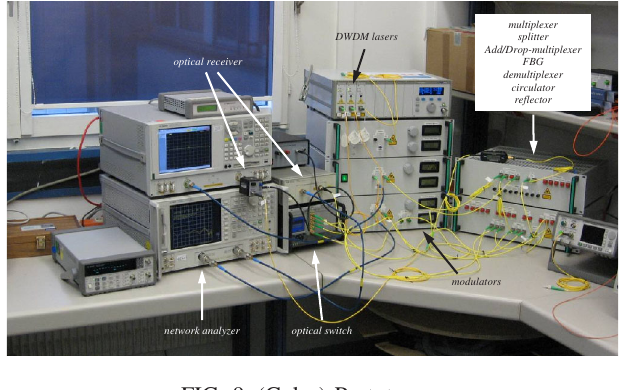
FIG. 9. (Color) Prototype.